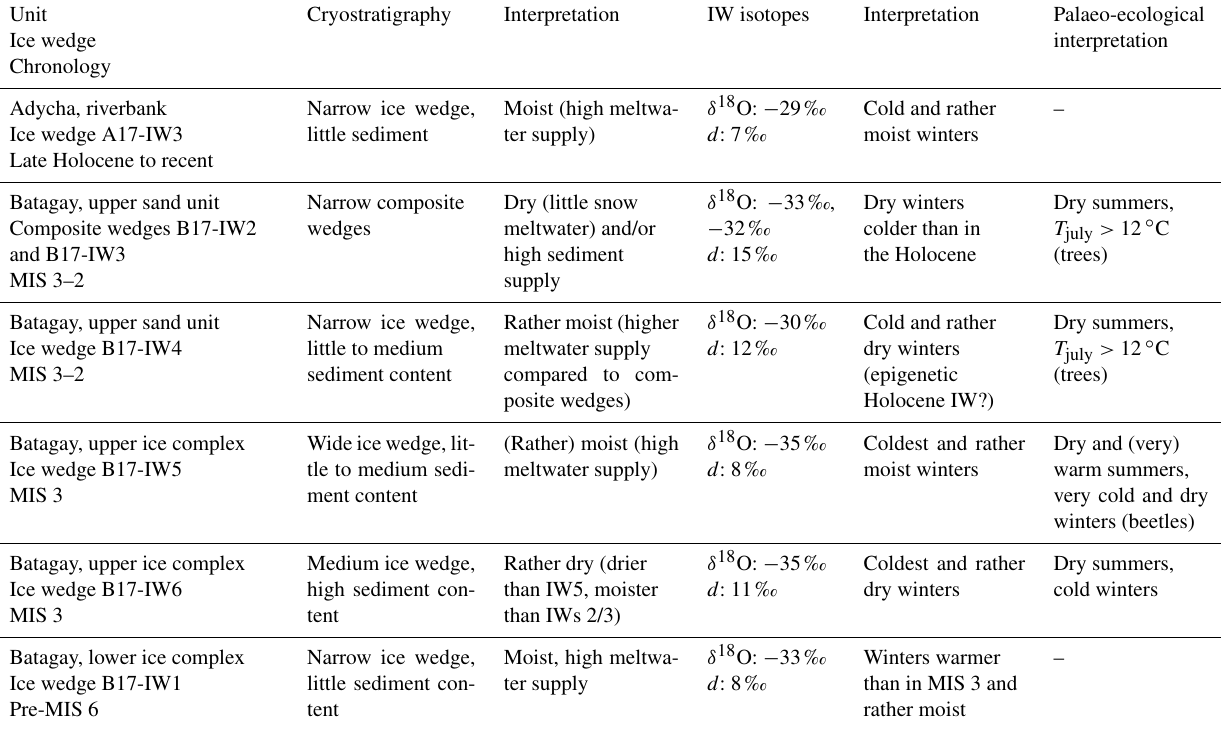
Table 4. Summary of past climate in the Yana Highlands. Palaeo-ecological interpretations are from Ashastina et al. (2018) and based on fieldwork in